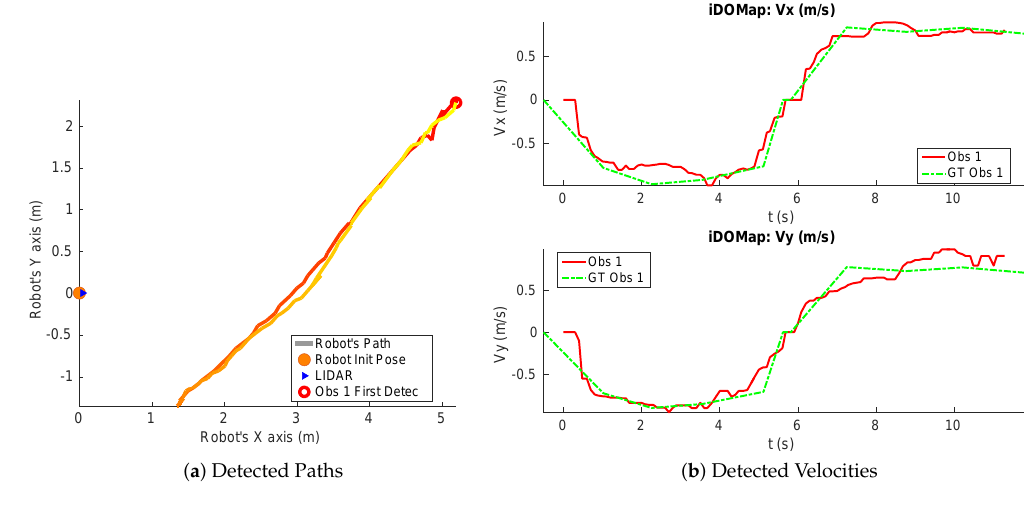
Figure 18. Real scenario 3—Path and detected velocities. Table 4. Real scenario 3—Errors in velocities detection.